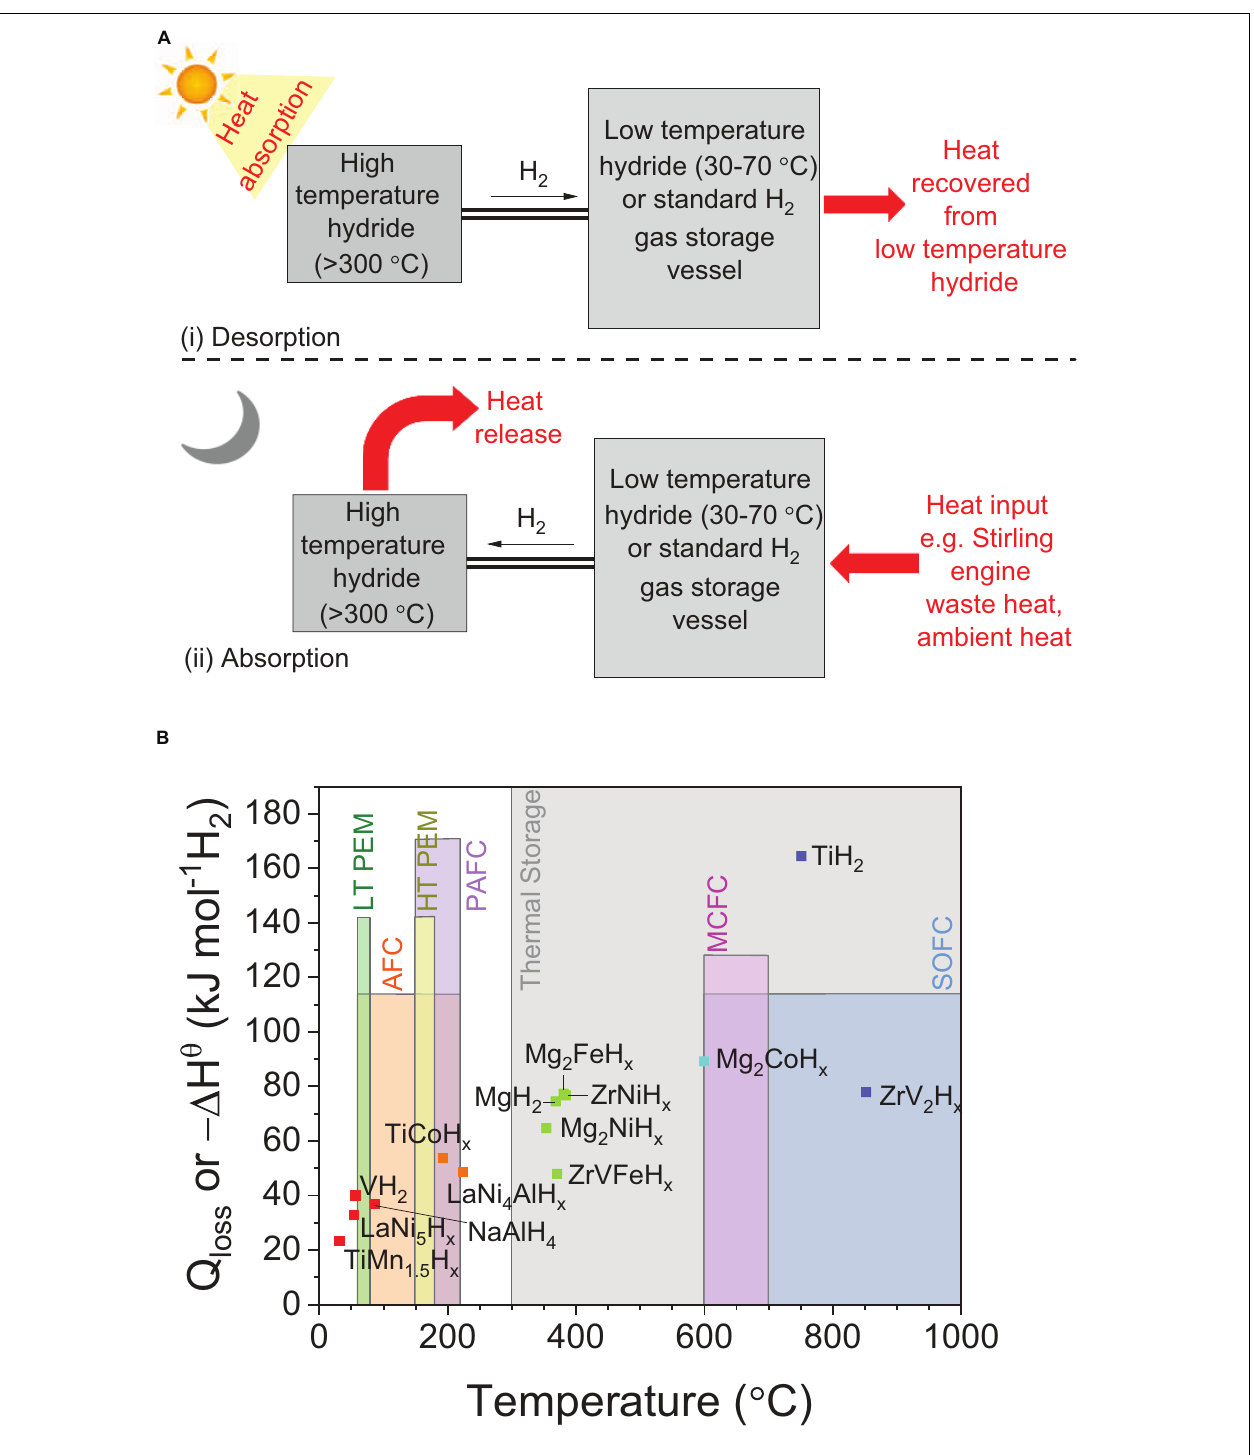
FIGURE 13 | (A) Schematic representation of using high-temperature hydrides in a closed system for thermal storage purposes under two scenarios: (i) desorption and (ii) absorption process where H 2 is being released and absorbed from high-temperature hydride, respectively (Felderhoff and Bogdanovi´c, 2009); (B) Evaluation of various metal hydrides with different fuel cell systems and their potential for being used as a thermal storage hydride. The desorption temperature values for metal hydrides are measured at 1 MPa plateau pressure. Q loss is associated with heat loss from fuel-cell systems, while – (cid:49) H θ represents the enthalpy of formation of the presented hydrides (Lototskyy et al., 2017; Pelay et al., 2017). For thermal storage applications, the high-temperature hydrides such as MgH 2 or TiH 2 can be linked to low-temperature hydrides such as TiMn 1 . 5 H x and LaNi 5 H x ( (cid:49) H θ ≈ 1/3 of high-temperature hydride) or a standard H 2 pressure vessel that can be used as temporary storage of hydrogen (Felderhoff and Bogdanovi´c,